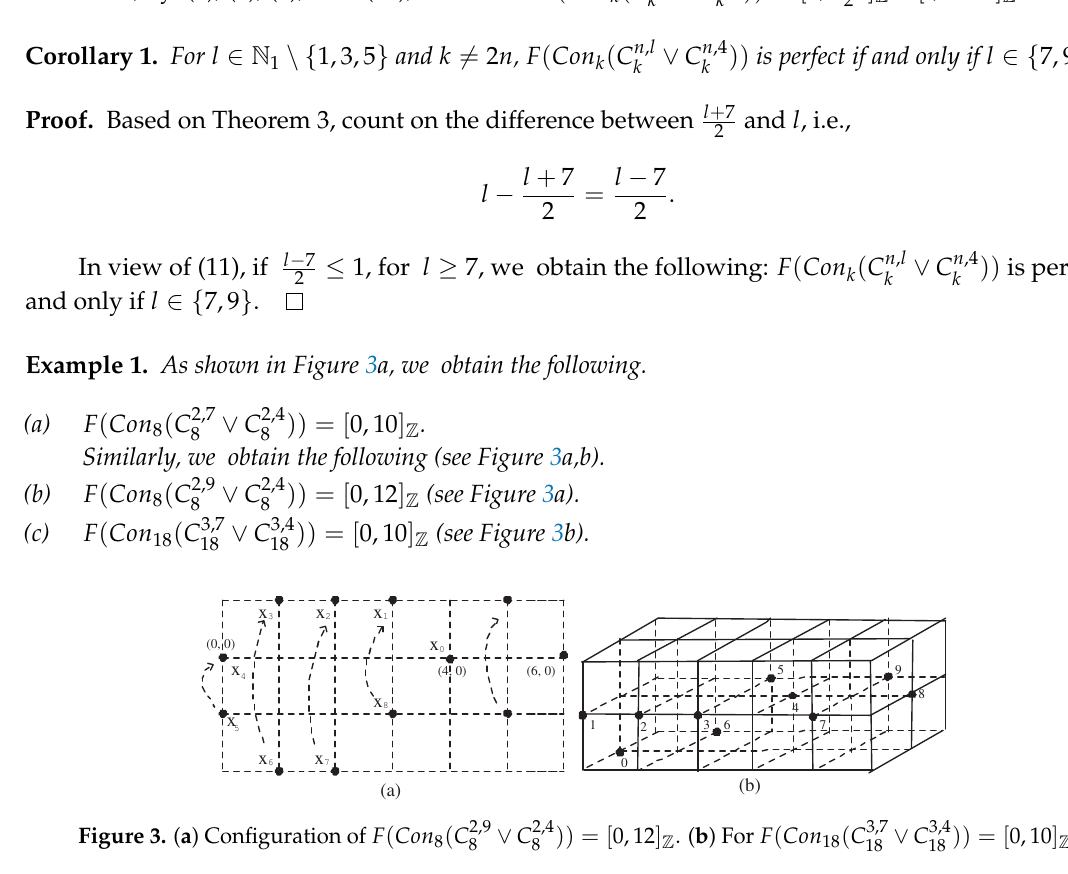
Figure 3. ( a ) Configuration of F ( Con 8 ( C 2,9